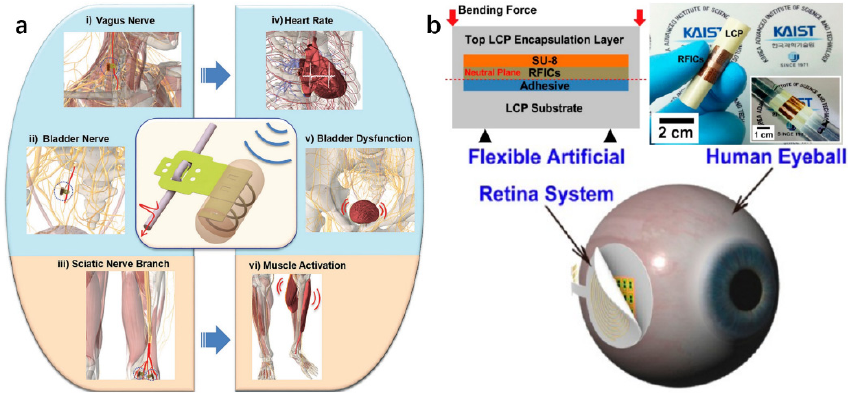
Figure 3. Flexible neural electrode based on polymer substrate material: ( a ) flexible nerve clip (FNC) electrode based on polyimide [76], and ( b ) flexible neural electrode based on LCP [90]. Table 3. Properties of polymeric substrates for neural implants.